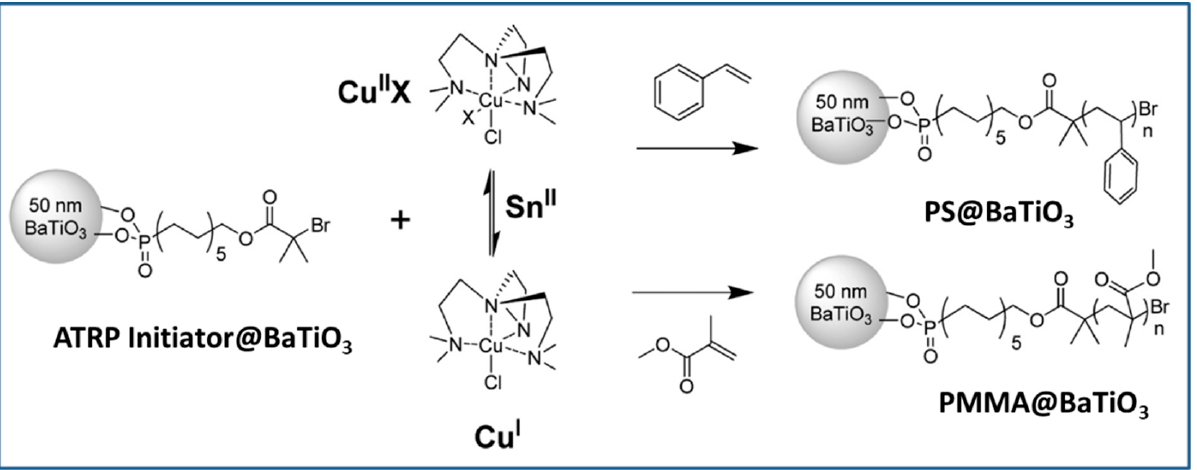
Figure 10. Surface-initiated polymerization of styrene or methyl methacrylate via ARGET ATRP. Reproduced with permission from Ref [27].